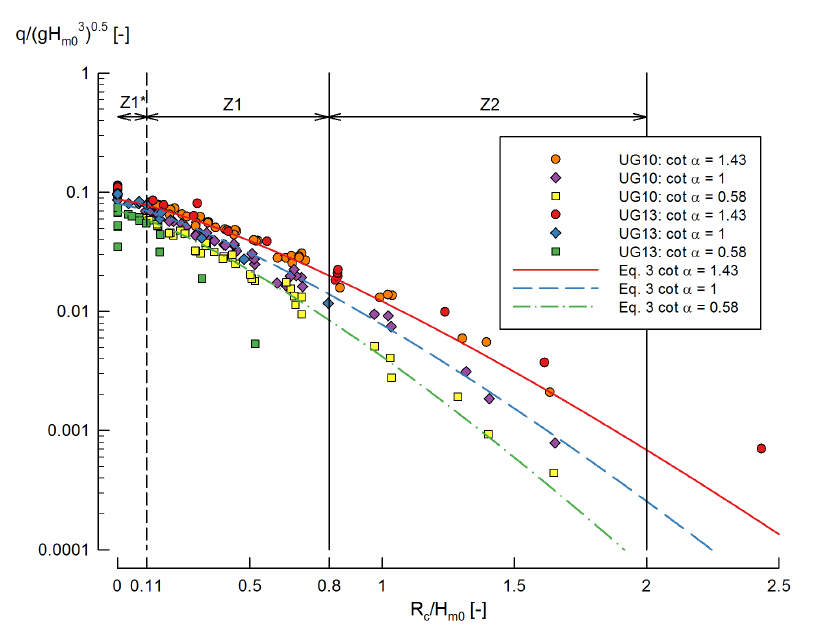
(cid:113) gH 3 as a function of the relative crest m 0